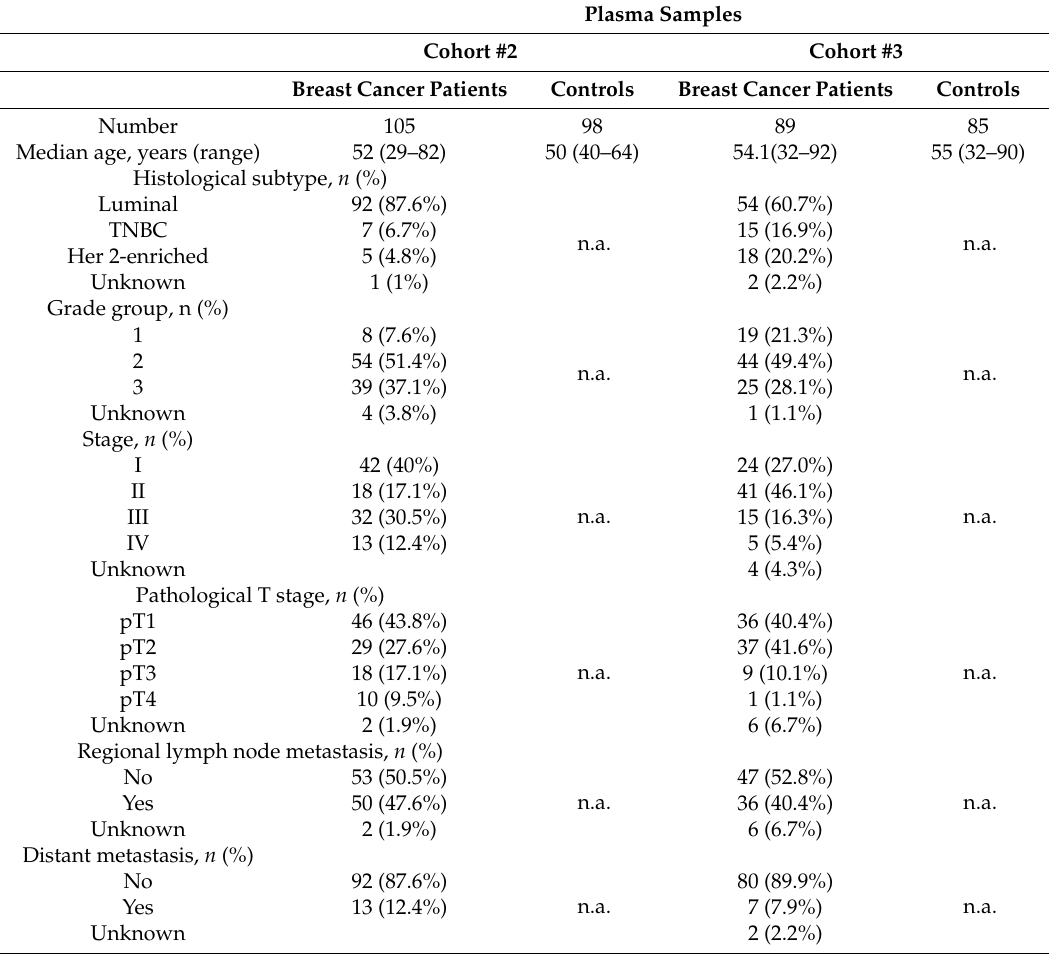
Table 3. Clinicopathological characteristics of breast cancer patients and controls of testing and validation cohorts: cohort #2 and cohort #3.